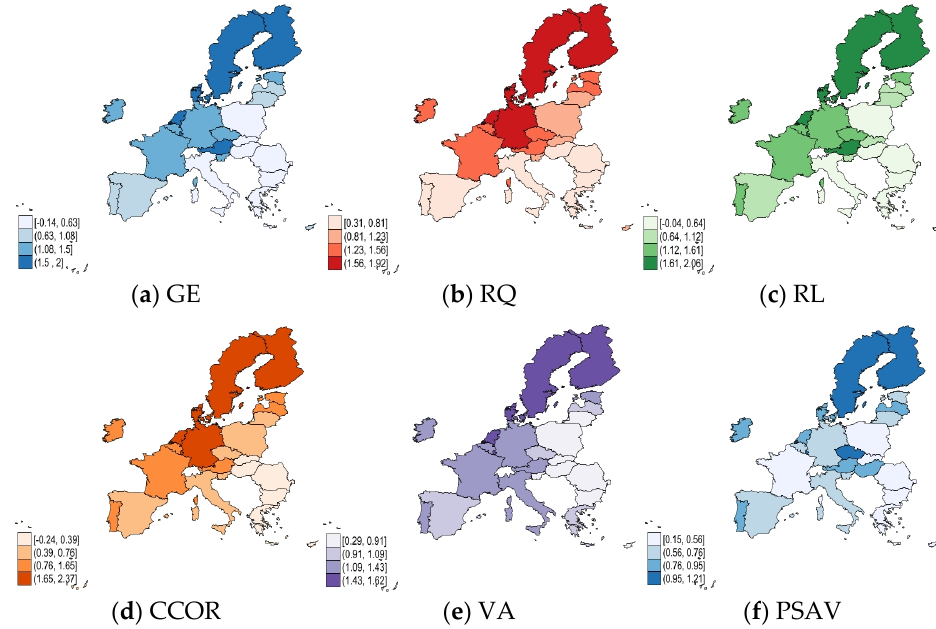
Figure 1. Governance indicators, EU-27, 2021. Source: Authors’ research in Stata17.